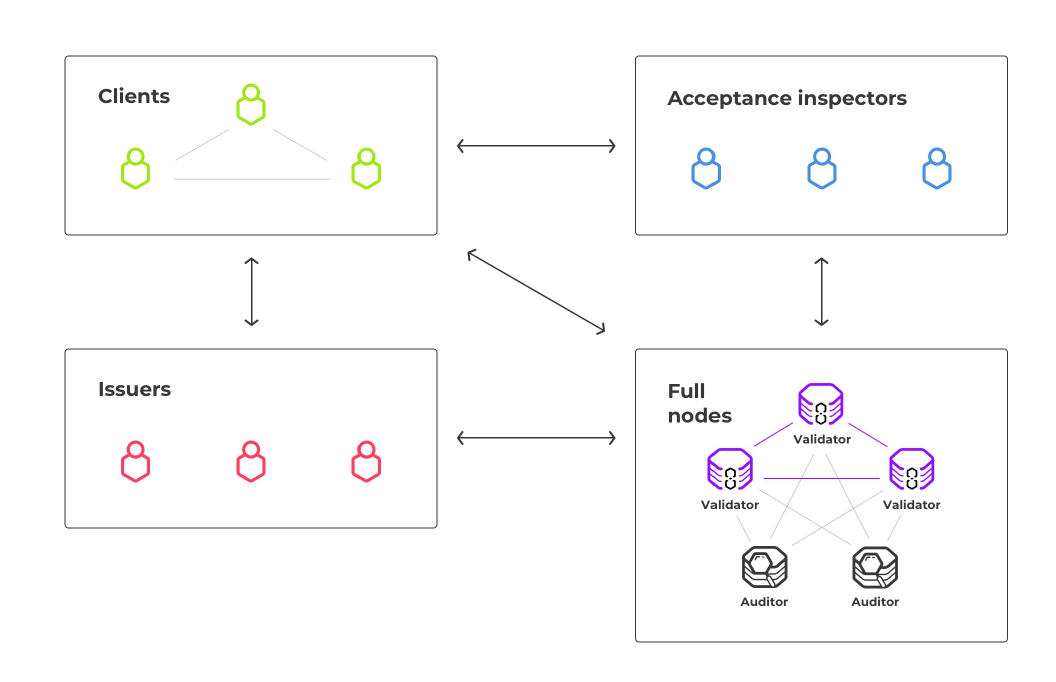
Figure 2. Blockchain network